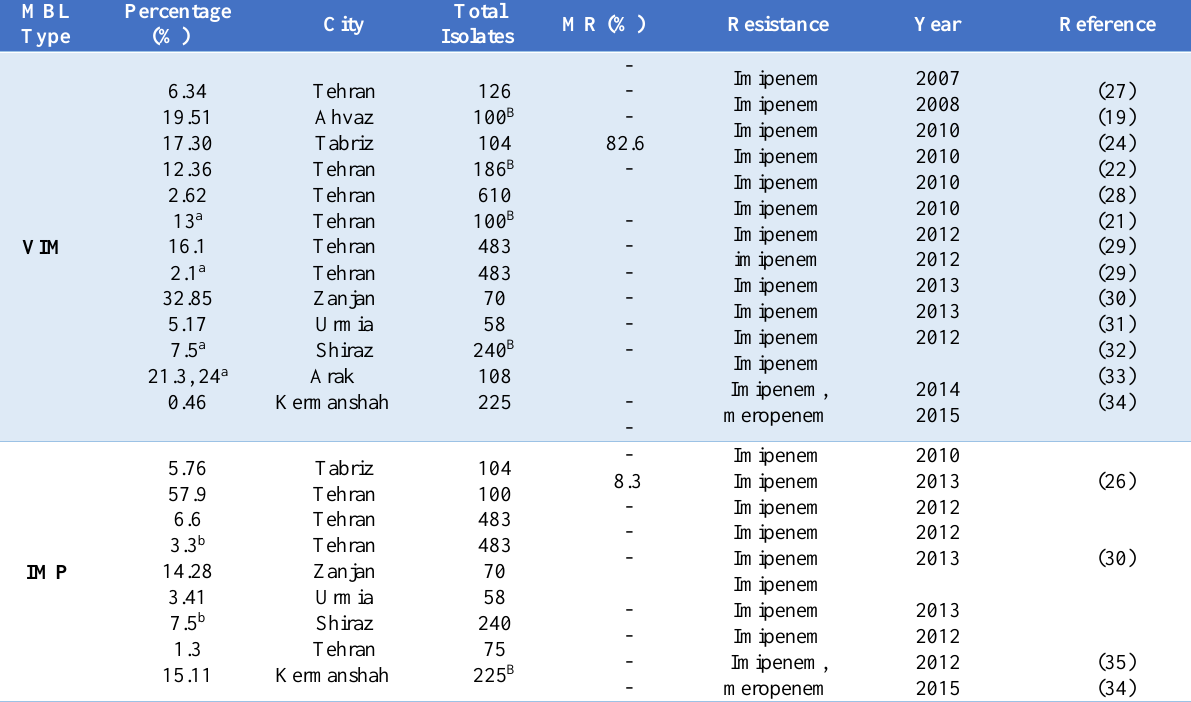
Table1. Phenotypic and Genotypic Prevalence of MBL Types in Different Cities of